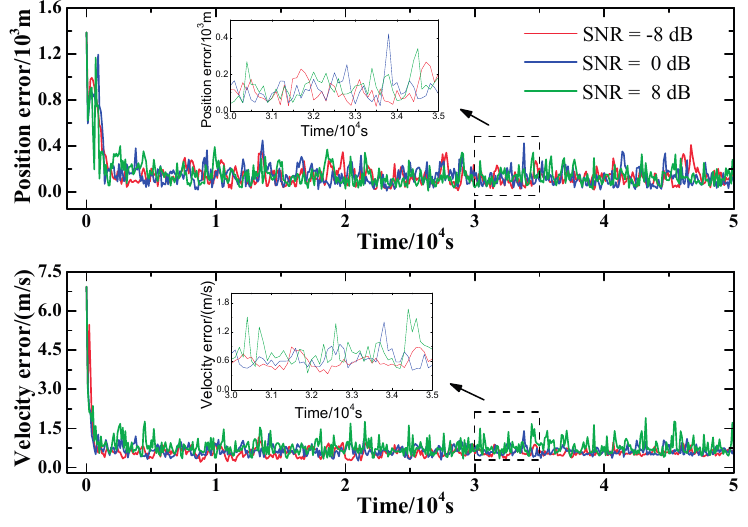
Figure 6. Influence of SNR on position and velocity